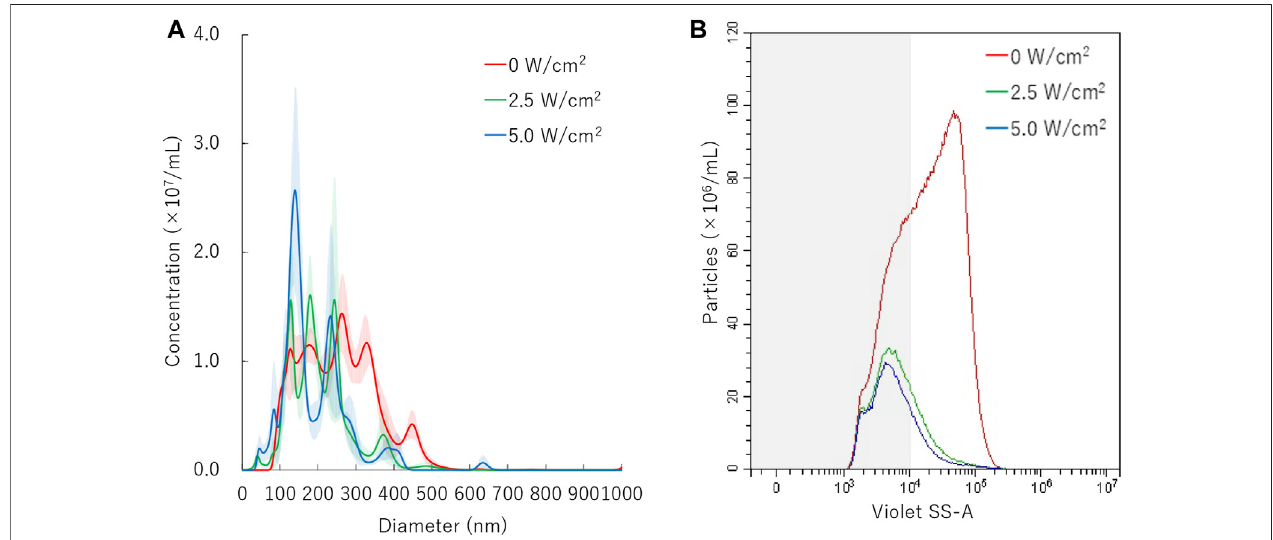
FIGURE 4 | Nanobubbles size distribution with various sonication intensities. (A) Size distribution of nanobubbles (NTA) with or without sonication. (B) The concentrations and size distribution of nanobubbles with or without sonication (FCM). Gray shaded area indicates nanobubbles size less 200 nm.